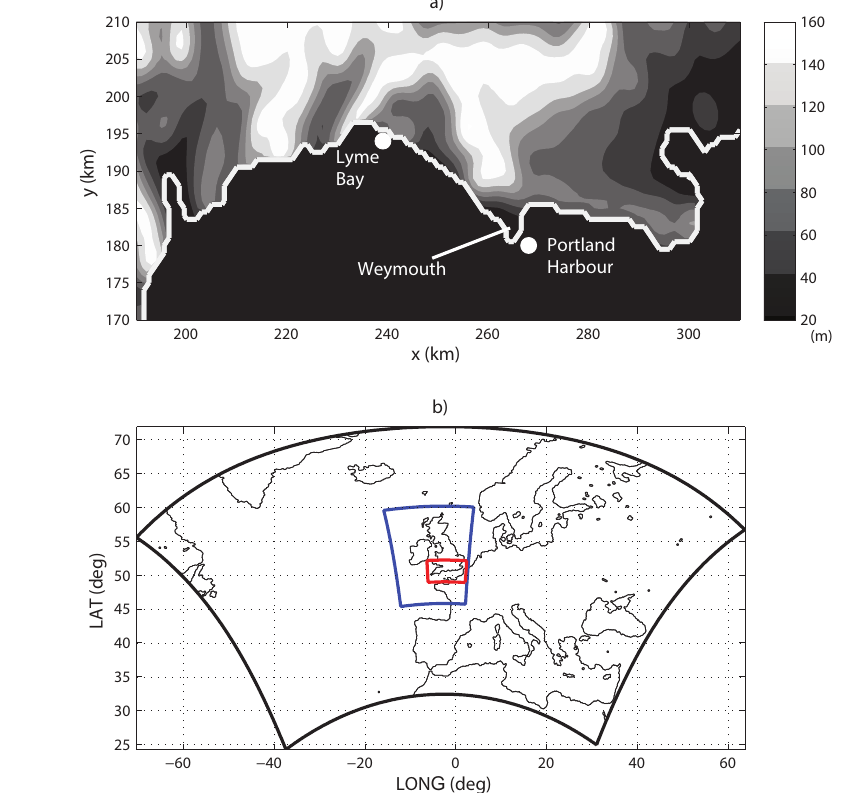
Fig. 1. (a) Orography in the vicinity of Weymouth as used in the 1km grid spacing MetUM simulation (note this is a subregion of the full domain used in the 1km simulation). (b) An approximation of the nested model domains. The area enclosed by the black border is the 12km grid spacing North Atlantic European (NAE) domain, the blue border encloses the 4km grid spacing UK domain, and the red border encloses the 1km grid spacing English Channel domain. The locations of the Portland Harbour and Lyme Bay observational platforms are depicted by the white circles in panel (a) (data shown in Fig.